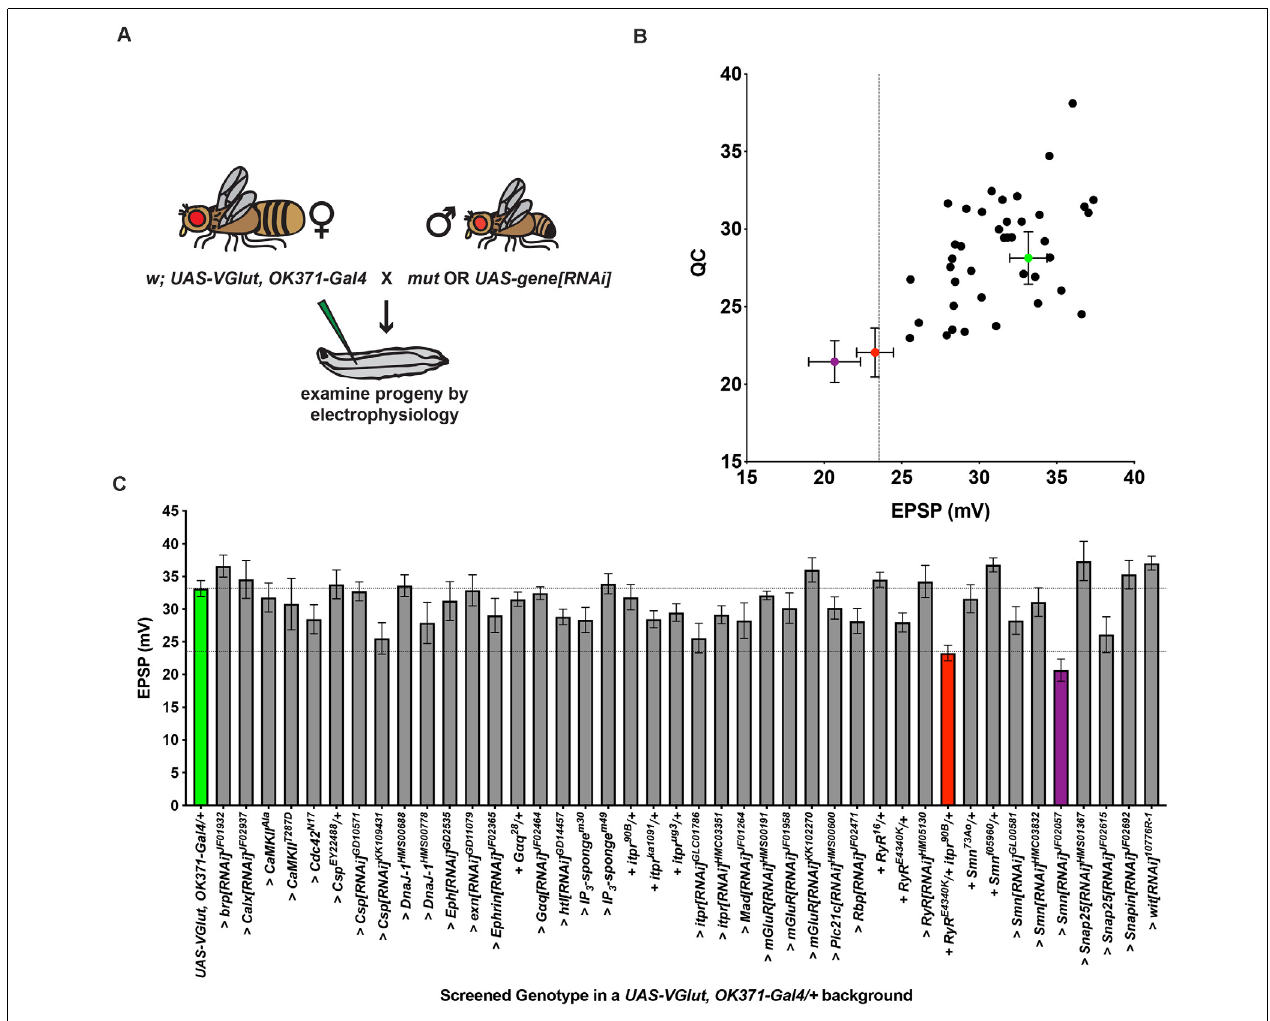
FIGURE 2 | An electrophysiology screen in a PHD-challenged genetic background. (A) Crossing scheme for generating larvae for electrophysiological recording. Each animal recorded had a homeostatic challenge provided by VGlut overexpression and a concurrent heterozygous or RNAi condition. Fly artwork